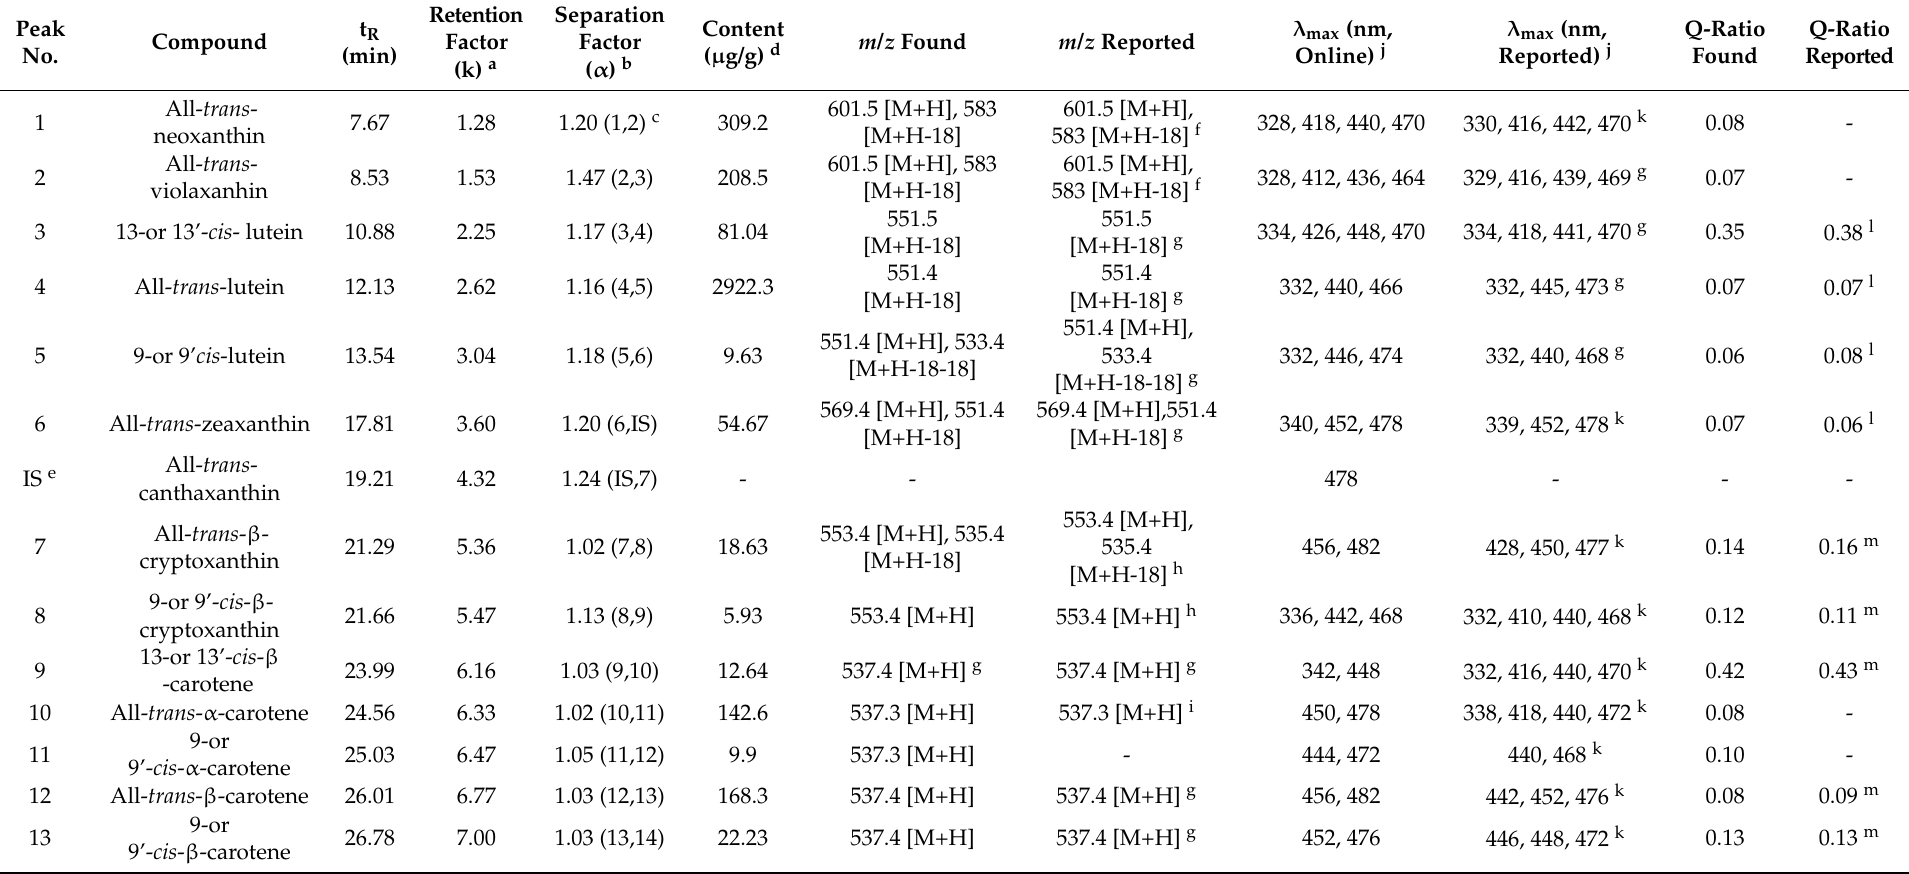
Table 1. Retention time (t R ), retention factor (k), separation factor ( α ), content ( µ g/g), m/z , λ max and Q-ratio of various carotenoids in pomelo